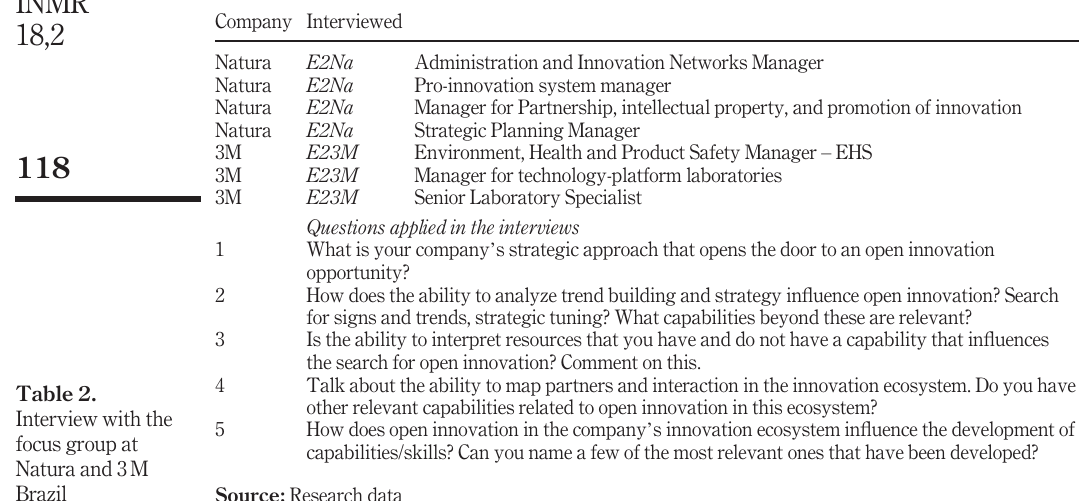
focus group at Natura and